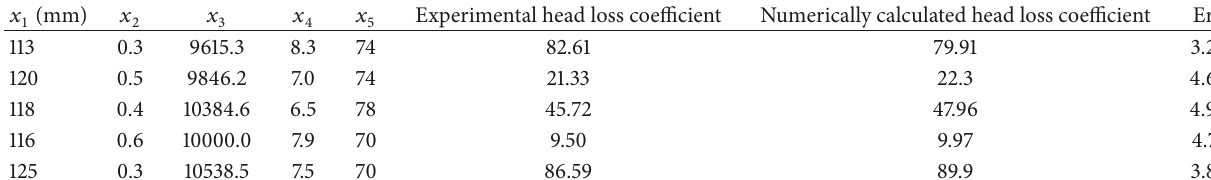
Table 3: Comparison of head loss coefficients calculated by regression equation and experimental results.